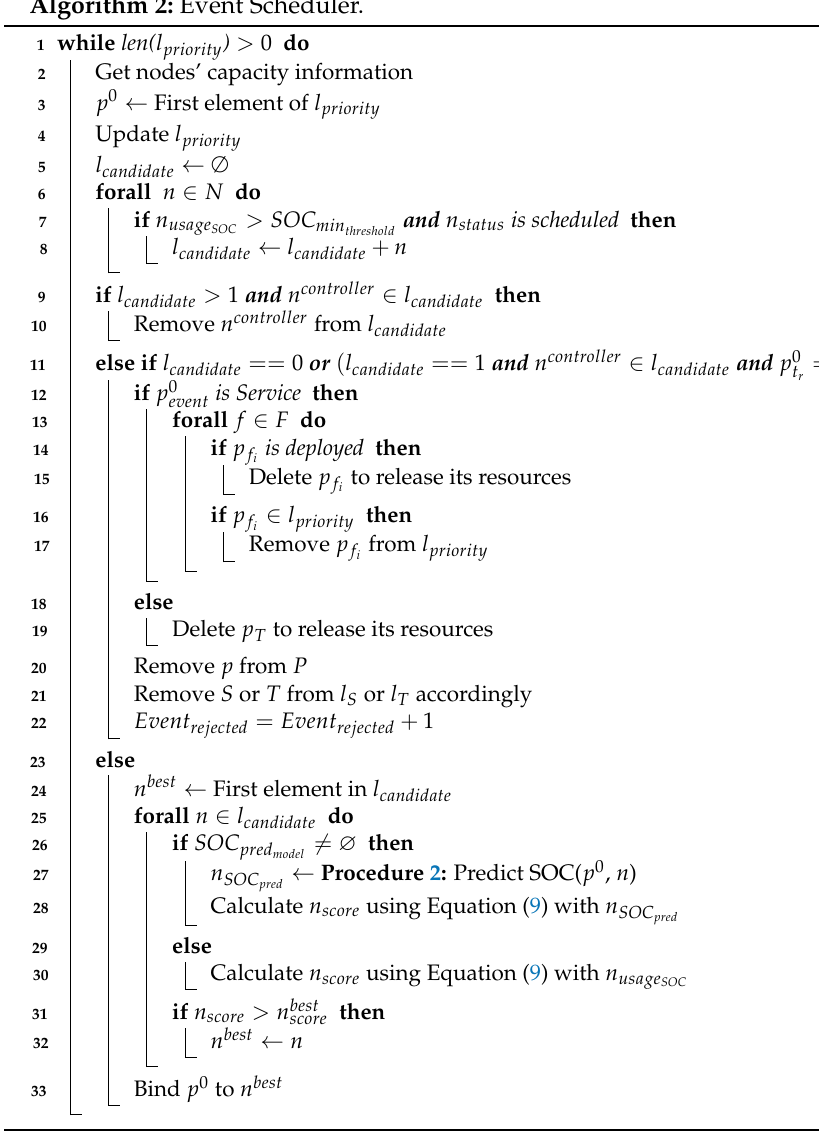
Algorithm 2: Event